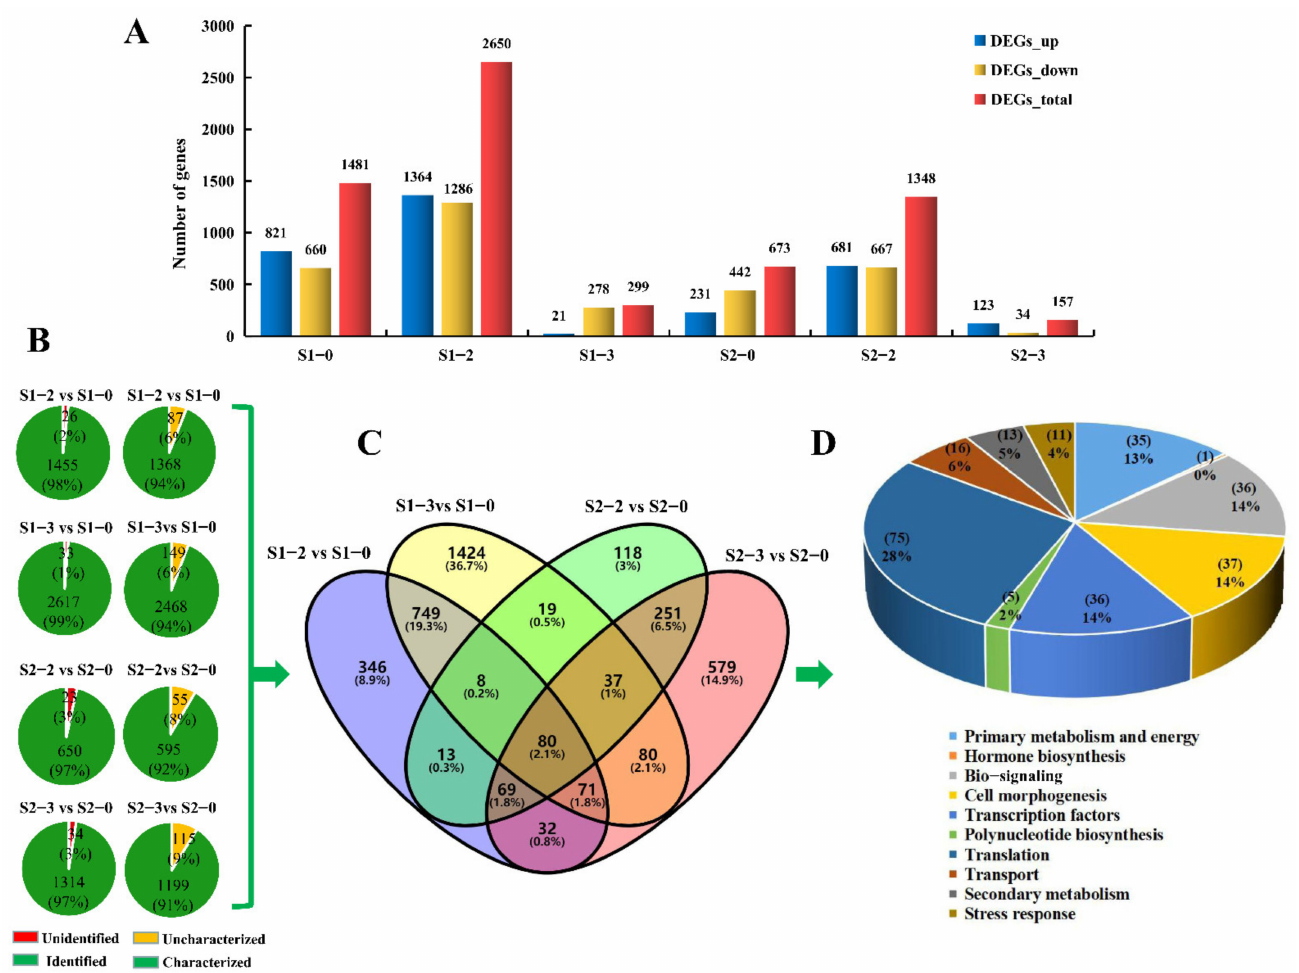
Figure 3. Distribution and classification of DEGs in apple fruit at different nitrogen levels (S1 and S2 periods). ( A ) The number of differential genes in S1–2 vs. S1–0, S1–3 vs. S1–0, S2–2 vs. S2–0, and S2–3 vs. S2–0. ( B ) Number and proportion of identified and characterized DEGs. ( C ) Venn